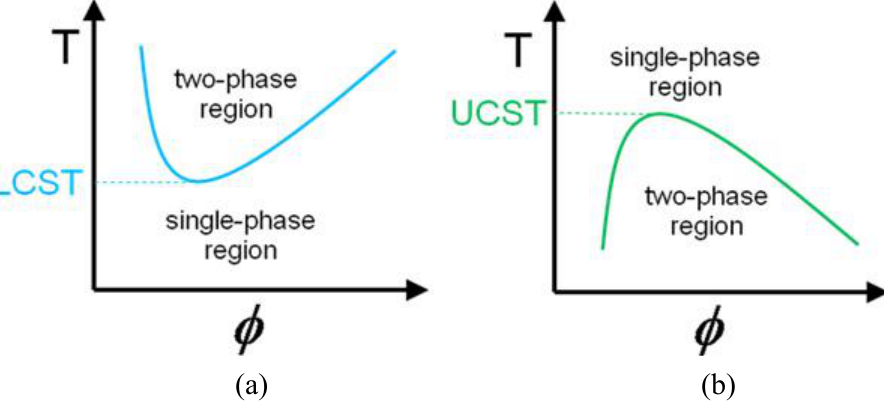
Figure 1. Temperature vs. polymer volume fraction, (cid:2038) . Schematic illustration of phase diagrams for polymer solution ( a ) lower critical solution temperature (LCST) behavior and ( b ) upper critical solution temperature (UCST)